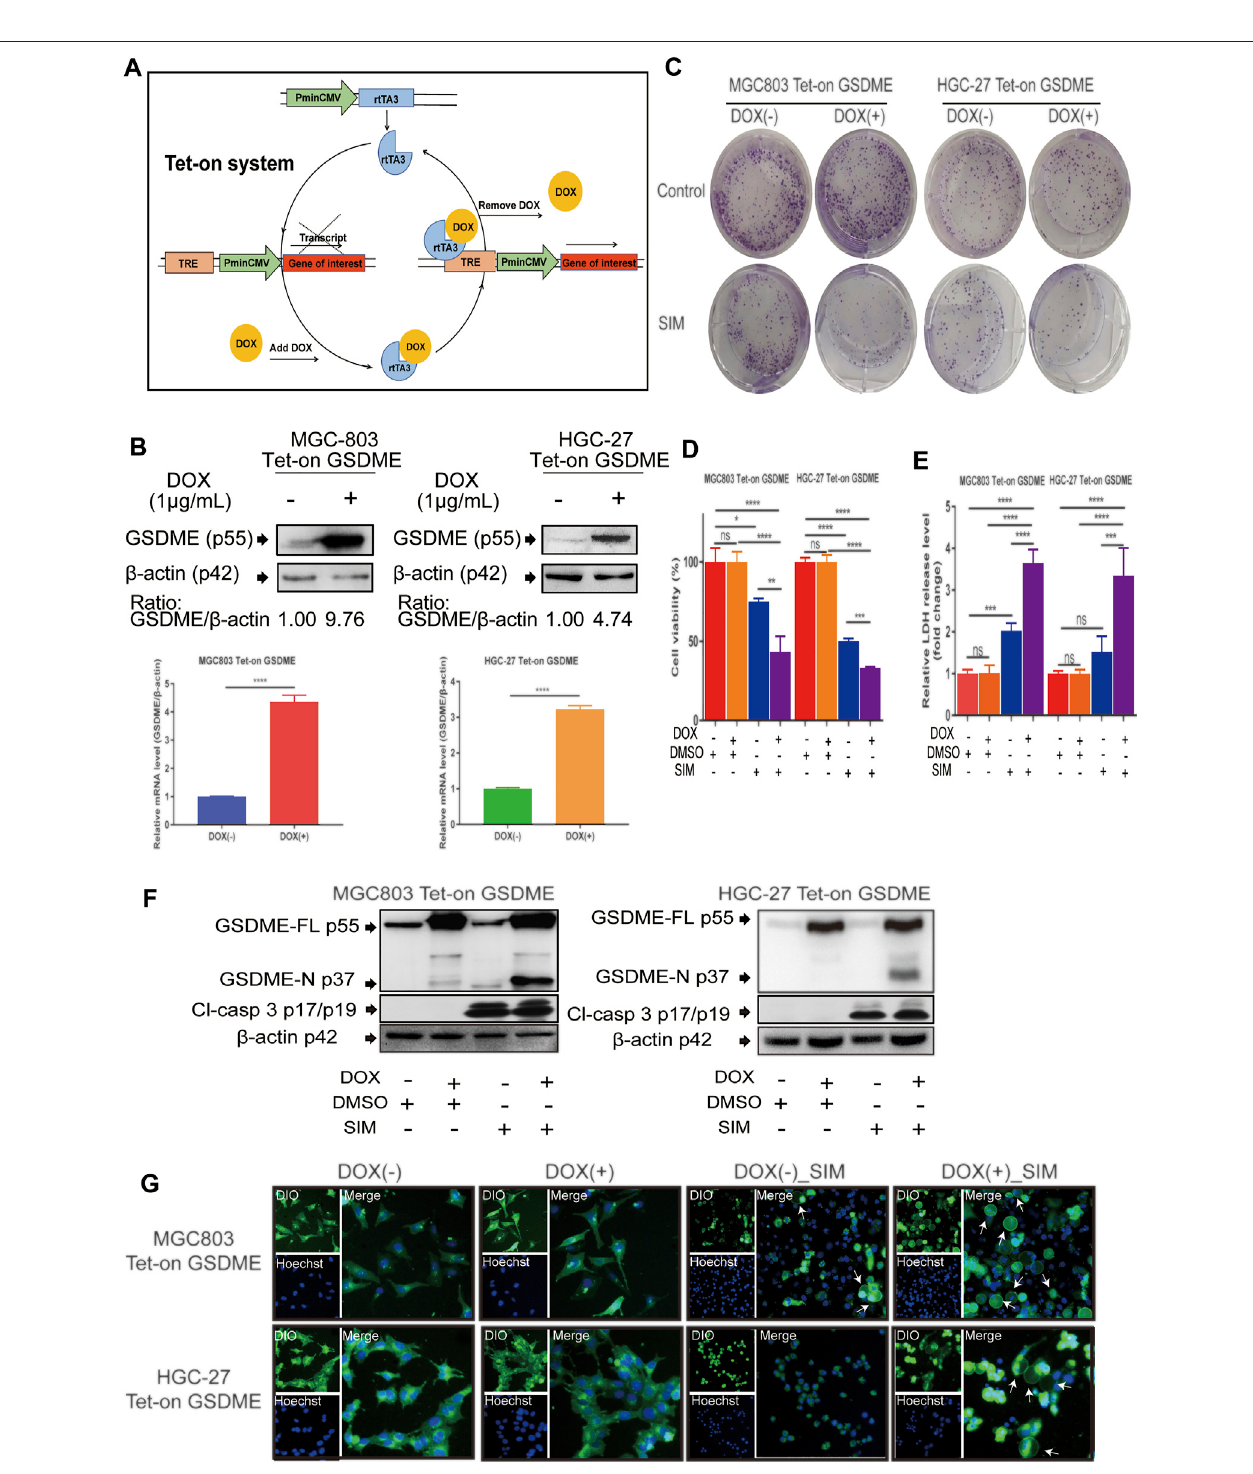
FIGURE 3 | Overexpression of GSDME enhanced SIM-induced cell pyroptosis. (A) Schematic representation of the DOX- controlled Tet-on system. (B) Validated ofGSDMEoverexpressioninMGC-803orHGC-27cellsbyWesternblottingandRT-qPCR.Colonyformation (C) ,Cellviability (D) ,LDHrelease (E) andproteincleavage of GSDME and caspase-3 (F) of GSDME-overexpressing MGC-803 and HGC-27 cells treated with SIM for 48 h. (G) Fluorescence microscopy imaging of GSDME- overexpressing MGC-803 and HGC-27 cells treated with SIM for 48 h, DIO (green fl uorescence) was used to dye cell cytomembrane, and Hoechst 33342 (Blue fl uorescence) the cell nucleus. White arrows indicate ballooned cell membrane; scale bar = 50 μ m. Data are shown as mean ± SD or representatives of at least three independent experiments. β -actin was used as an internal control for Western blot. p p < 0.05, pp p < 0.01, ppp p < 0.001 and pppp p < 0.0001.